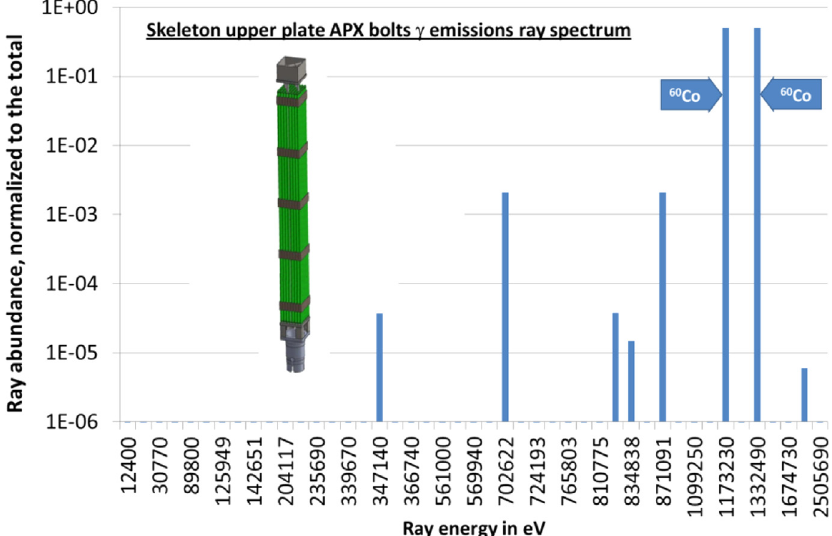
Fig. 6. PHEBUS sub-assembly skeleton typical g emissions (Ray